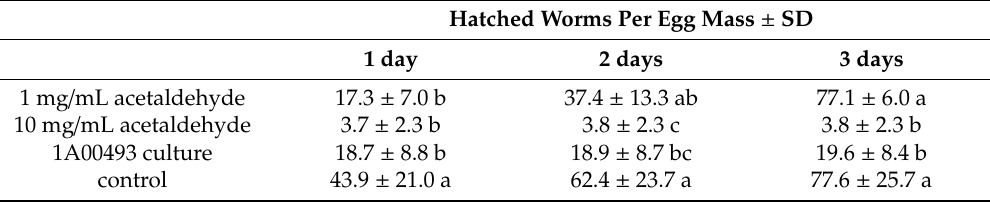
Table 4. E ff ect of acetaldehyde and bacterial culture to M. incognita ’s egg hatching.